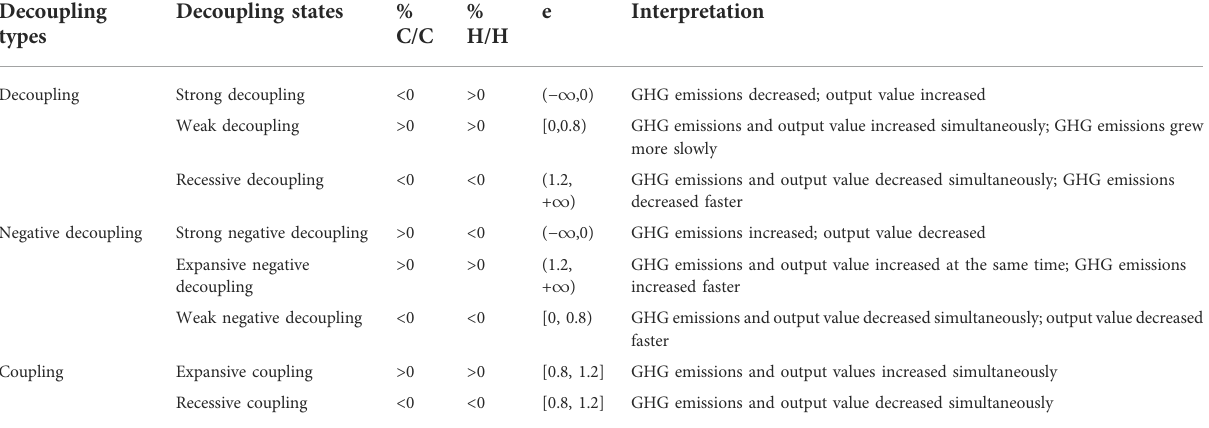
TABLE 2 Classi fi cation of and criteria for decoupling relationships among livestock GHG emissions and livestock